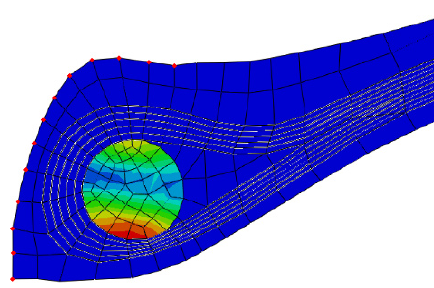
Figure 11. Tire nodes adhering to the reference rim point.